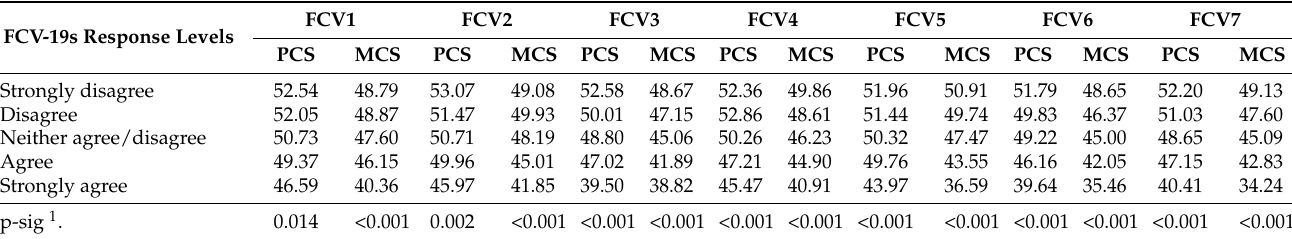
Table 2. Physical and mental component scores by FCV-19s response